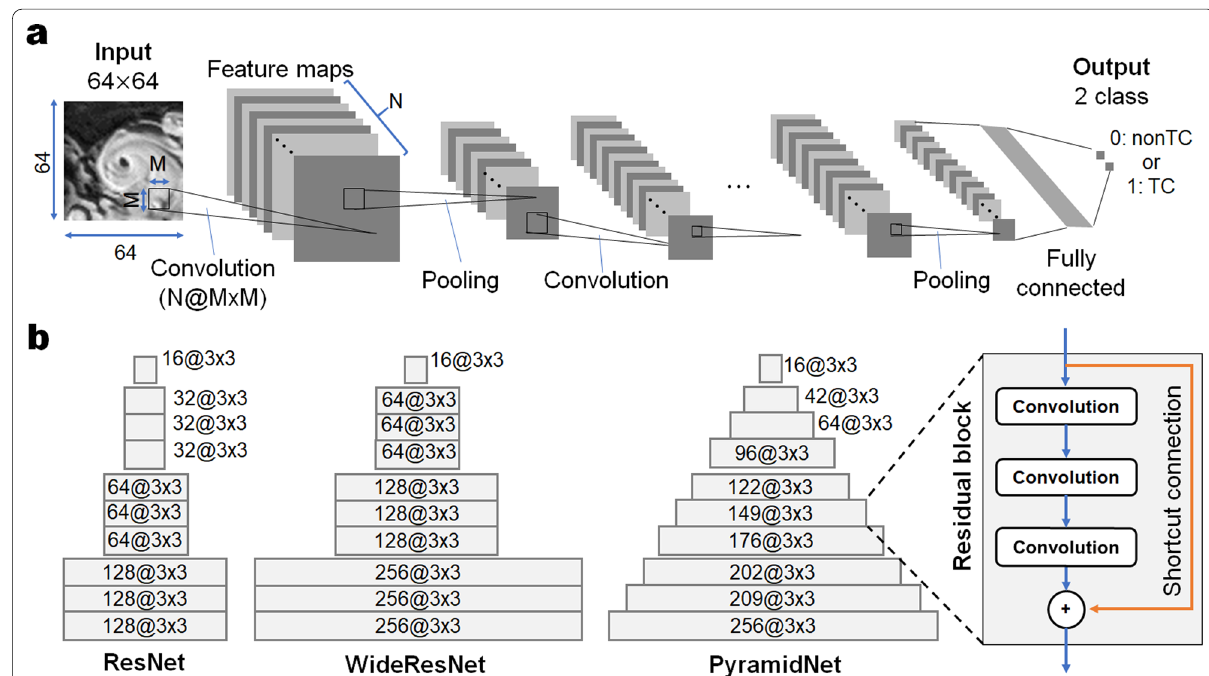
Fig. 2 Convolutional neural networks (CNNs) for binary classification. Basic architectures of a simple CNN, and b residual networks: ResNet (He et